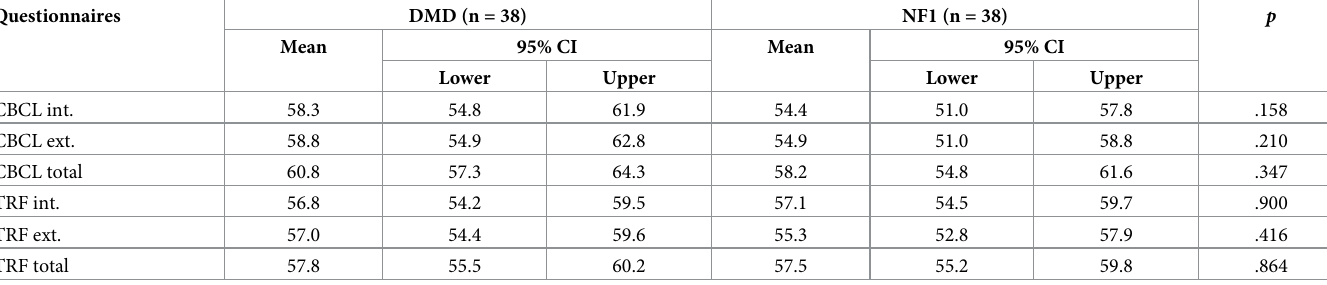
Table 6. Multivariate analyses of behavioral reports of parents and teachers of the DMD and NF1 group. Questionnaires